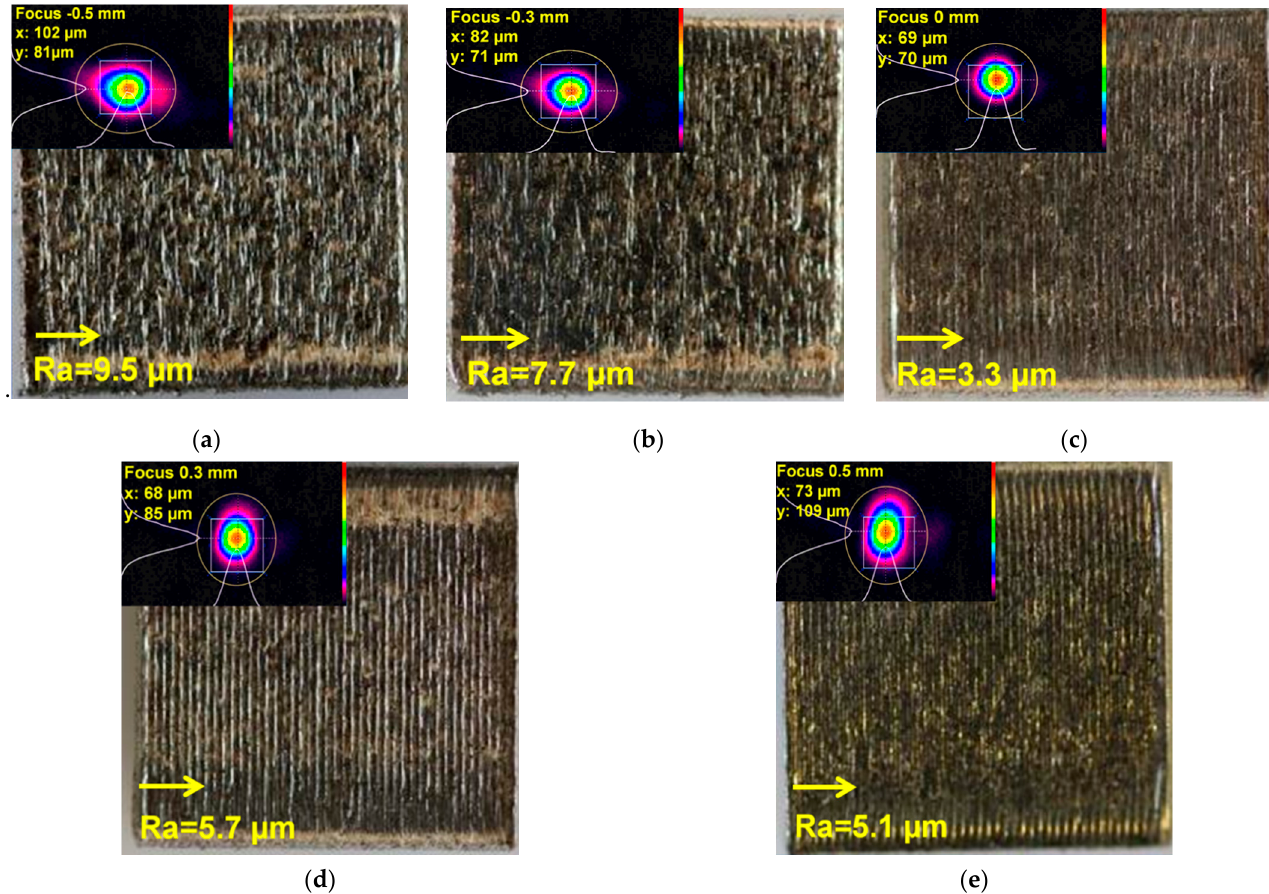
Figure 3. Macroscopic top-view images of the manufactured specimens built with different defocusing distances: ( a ) − 0.5 mm, ( b ) − 0.3 mm, ( c ) 0 mm, ( d ) 0.3 mm, and ( e ) 0.5 mm.